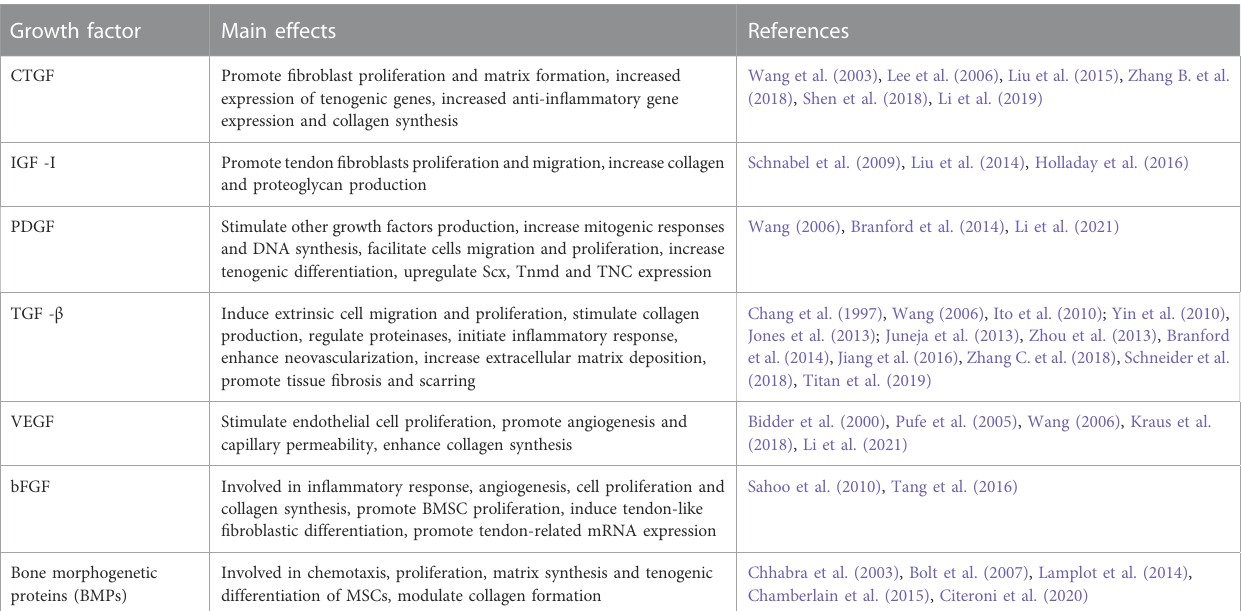
TABLE 3 Summary of the main growth factors for tendon tissue